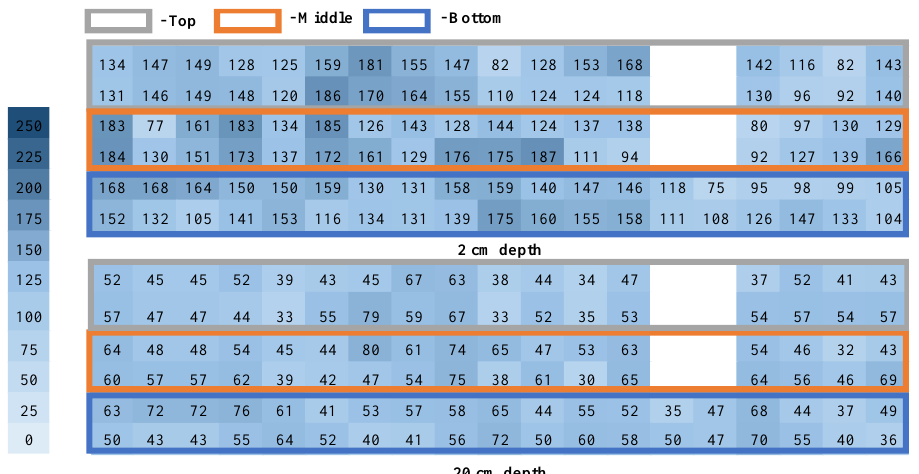
Fig. 4. Moisture distribution in the wall, March 5 th , year